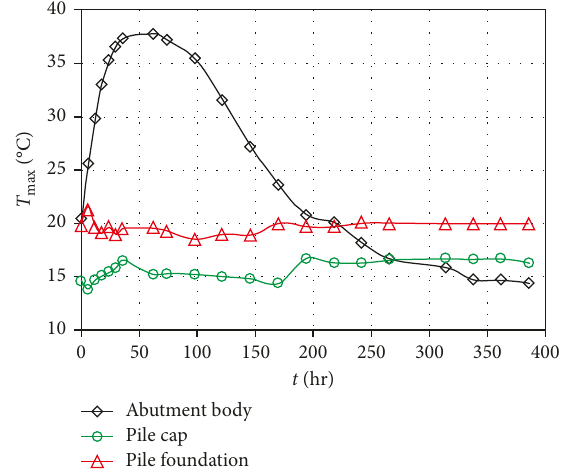
Figure 7: Change of abutment temperature with time of hydration heat.